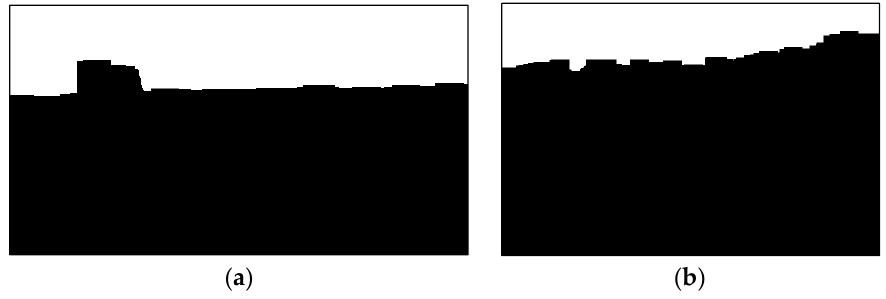
Figure 5. The detected sky region (marked as white area) for Figure 2 using our method. ( a ): The detected sky region (marked as white area) for Figure 2a (left). ( b ) The detected sky region (marked as white area) for Figure 2a (right).